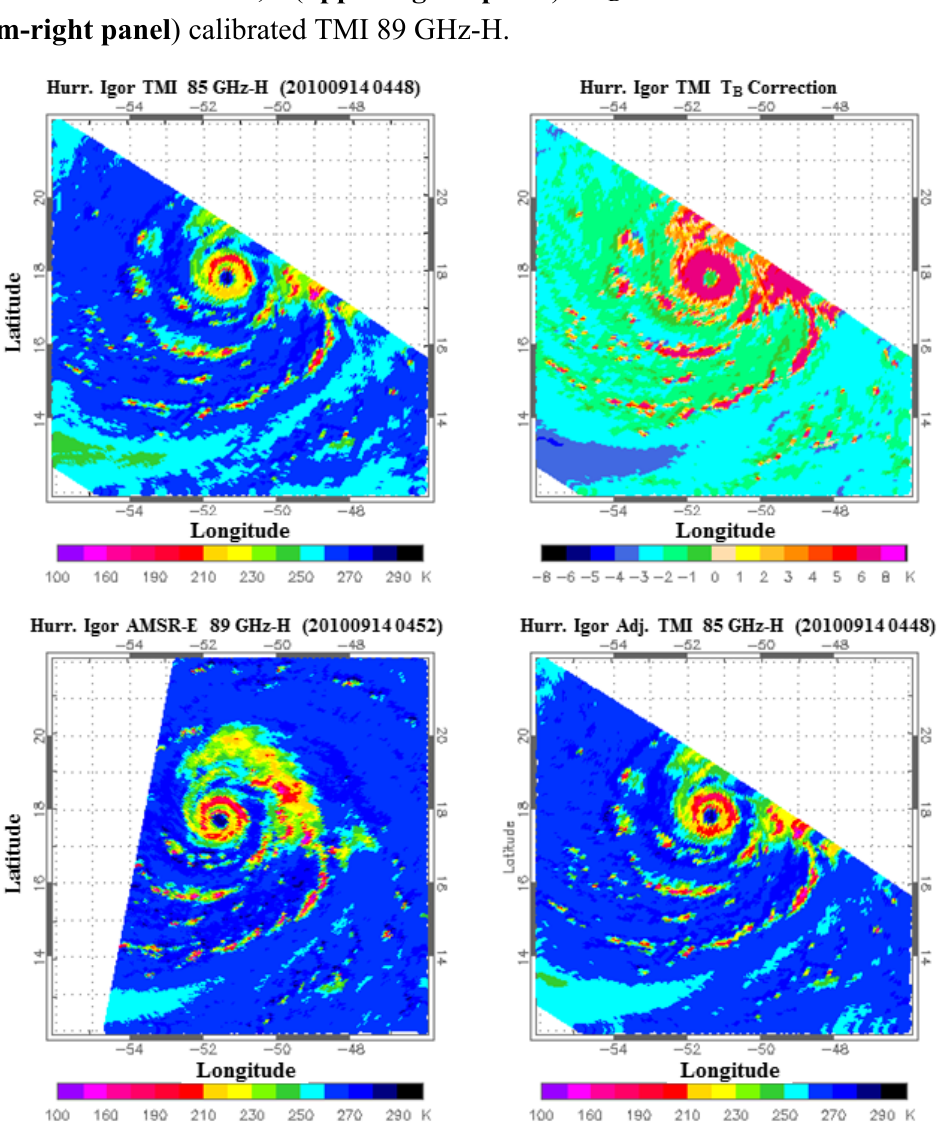
correction distribution; and B